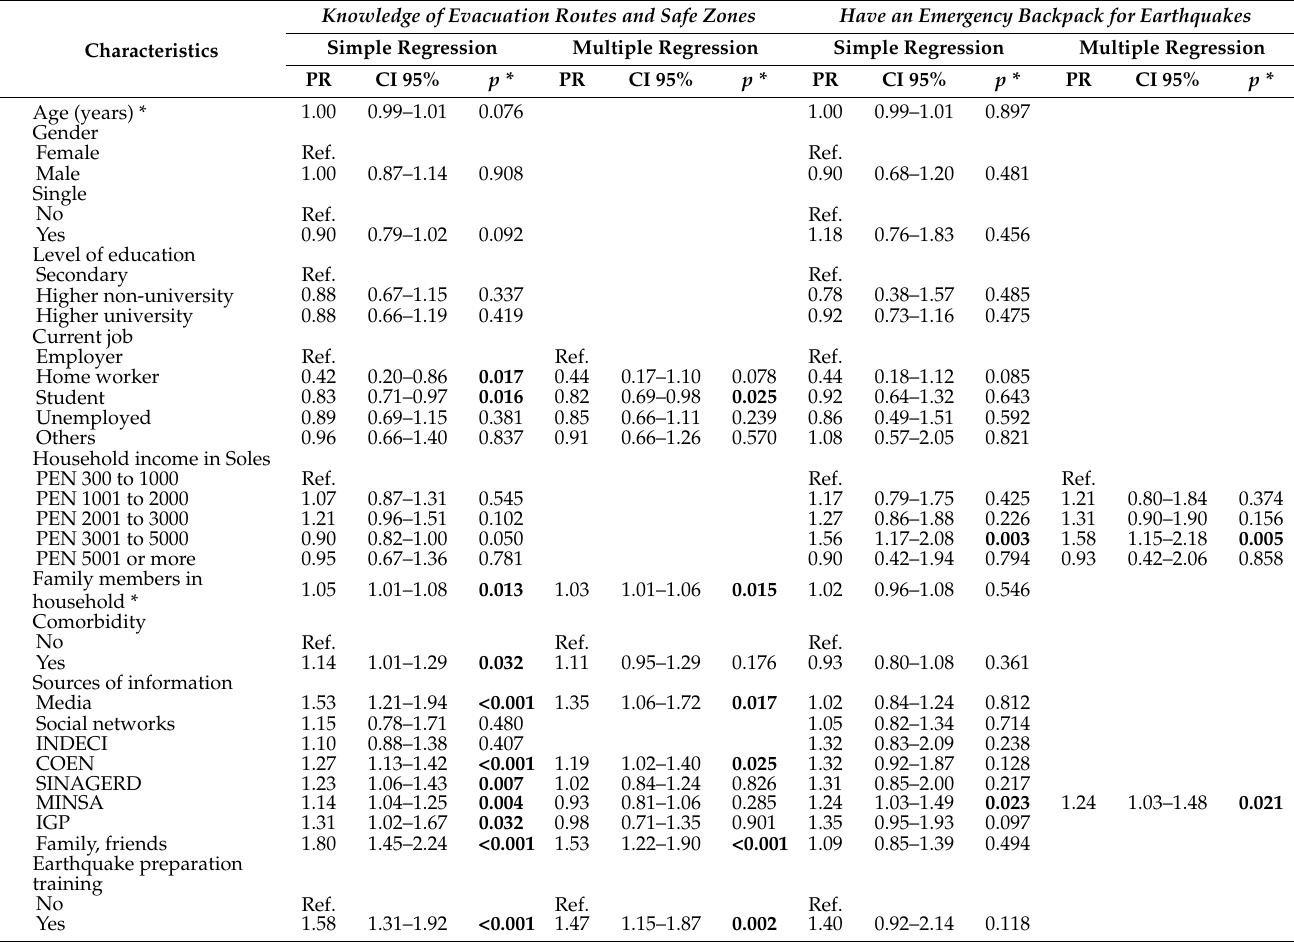
Table 3. Factors associated with knowledge about evacuation routes and having an emergency backpack in case of earthquakes, in simple and multiple regression